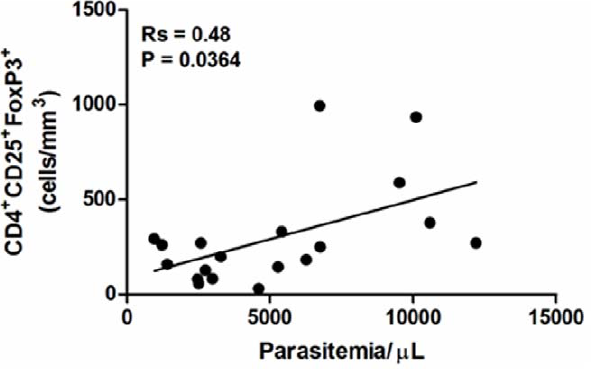
Figure 4. CD4 + CD25 + FoxP3 + regulatory T cells are directly correlated with parasite burden. The relationship between absolute numbers of CD4 + CD25 + FoxP3 + regulatory T cells and degree of parasitaemia among 20 patients with Plasmodium vivax malaria